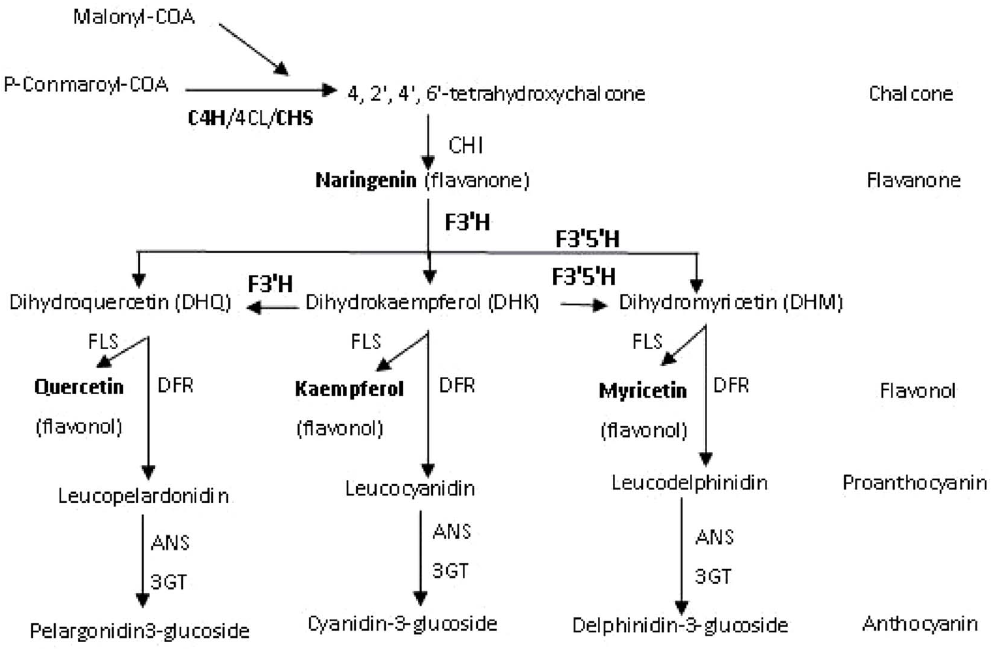
Figure 1. Schematic representation of the flavonoid biosynthetic pathway modified from [ 24–26 ] . C4H: Cinnamate-4-hydroxylase; 4CL: 4-Coumarate acyl-COA ligase; CHS: chalcone synthase; CHI: chalcone isomerase; F3 9 H: flavonoid-3 9 -hydroxylase; F3 9 5 9 H: flavonoid-3 9 5 9 -hydroxylase; FLS: flavonol synthase; DFR: dihydroflavonol reductase; ANS: Anthocyanidin synthase; 3GT: 3-O-glucosyltransferase.